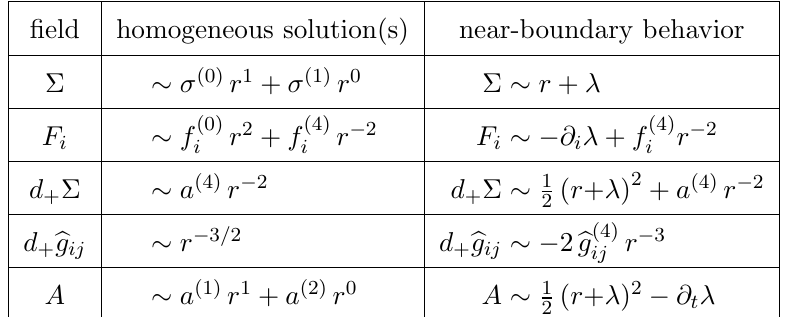
Table 1 . Near-boundary asymptotic behavior of the homogeneous solutions to the radial di(cid:11)erential equations (2.8a){(2.8e) for the indicated (cid:12)elds, together with the desired asymptotic behavior of physical solutions. The asymptotic coe(cid:14)cients a (4) , f (4) density, momentum density, and traceless stress tensor of the dual (cid:12)eld theory. The leading terms in the near-boundary behavior of all (cid:12)elds except (cid:6) are driven by the inhomogeneous source terms in the various equations and do not correspond to homogeneous